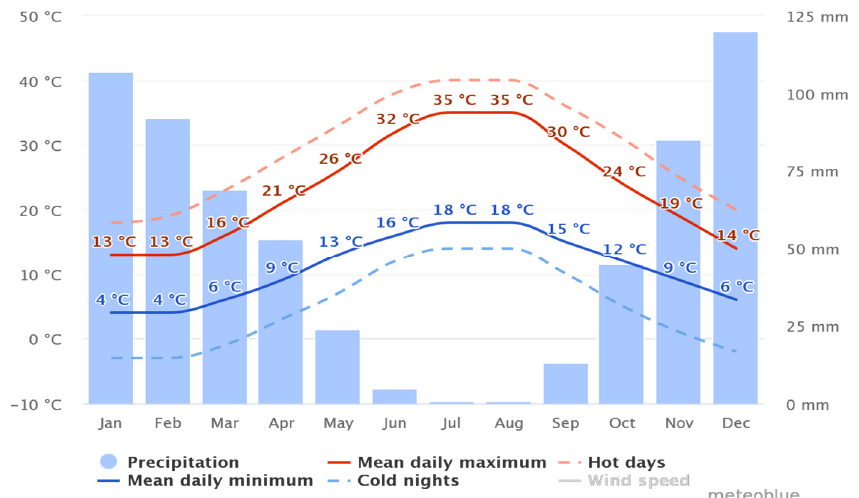
Figure 3. Annual fluctuation of temperature and rainfall in the island of Chios. The solid red line shows the maximum temperature for an average day for every month on Chios; the solid blue line shows the average minimum temperature; the dashed red and blue lines show the average of the hottest day and coldest night of each month for the last 30 years. The period between June and September is dominated by hot and dry conditions, ideal for the ignition and propagation of fires (Source: meteoblue).